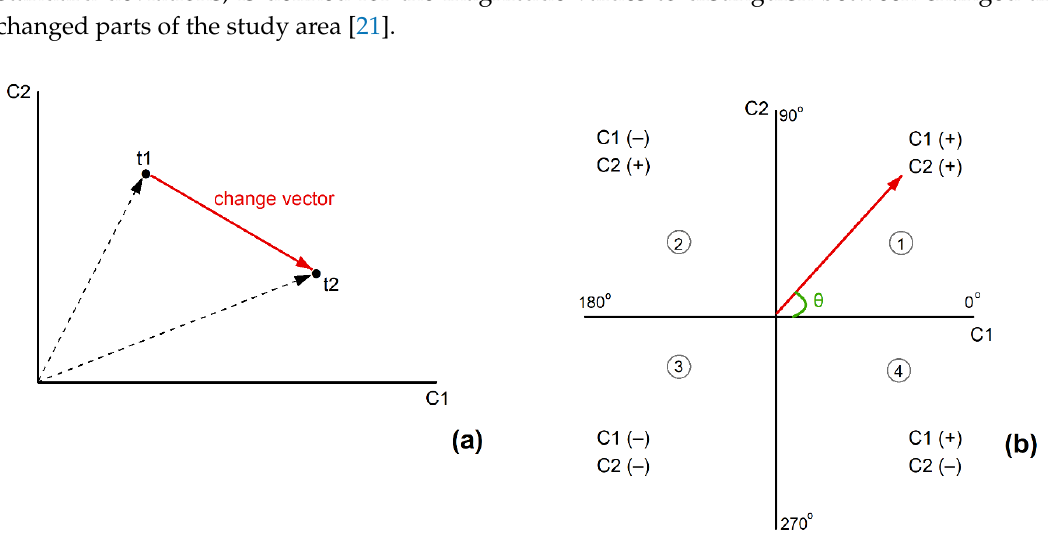
Figure 2. The concept of change vector analysis for two-dimensional space: ( a ) change magnitude; ( b ) change direction.